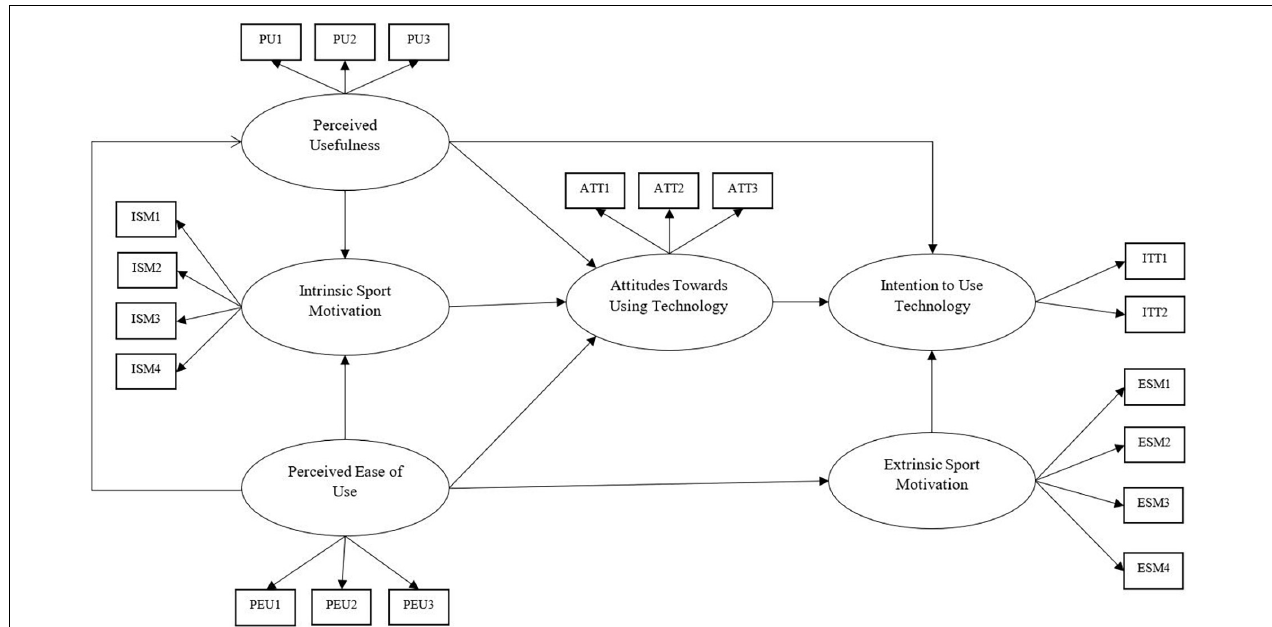
FIGURE 1 | Hypothesized model (permission for using TAM in the current research has been obtained from the